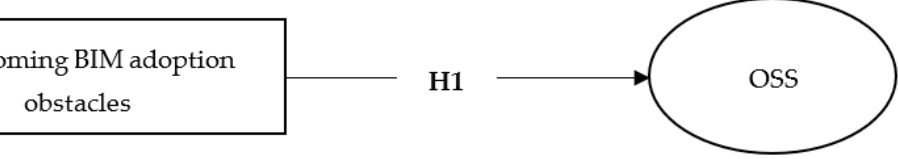
Figure 1. Influence of BIM implementation barriers on the adoption of